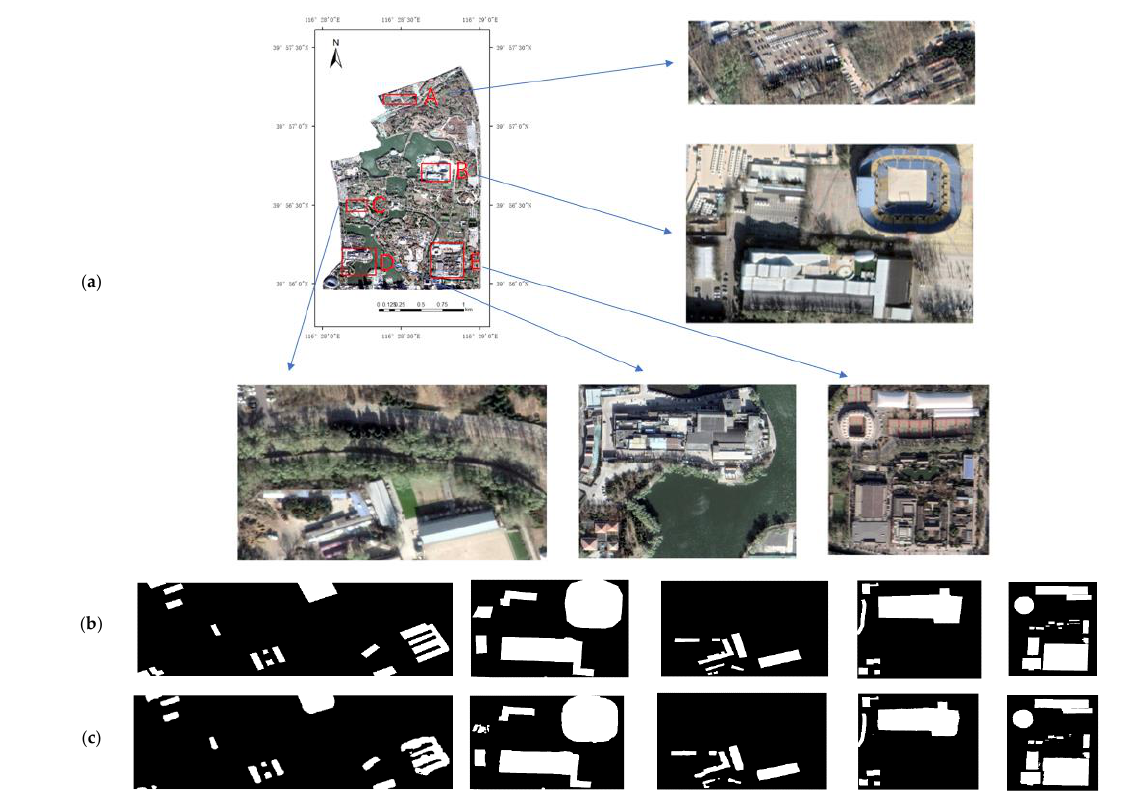
Figure 8. Extraction results of buildings in emergency shelters of Chaoyang Park. ( a ) Google image. ( b ) Building ground truth. ( c ) Building extraction results.